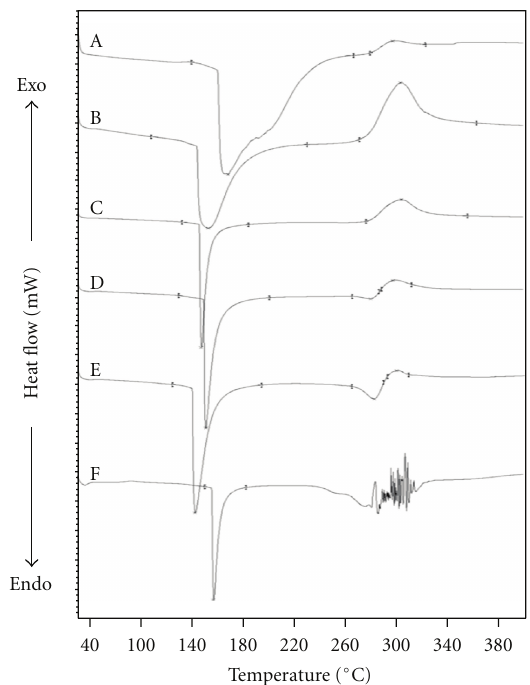
Figure 3: DSC thermograms of (A) CS film and CS/SF blend films with various blend ratios of chitosan:fibroin (CF) of (B) 3 :1, (C) 2:1, (D) 1: 1, (E) 1 :2, and (F) SF